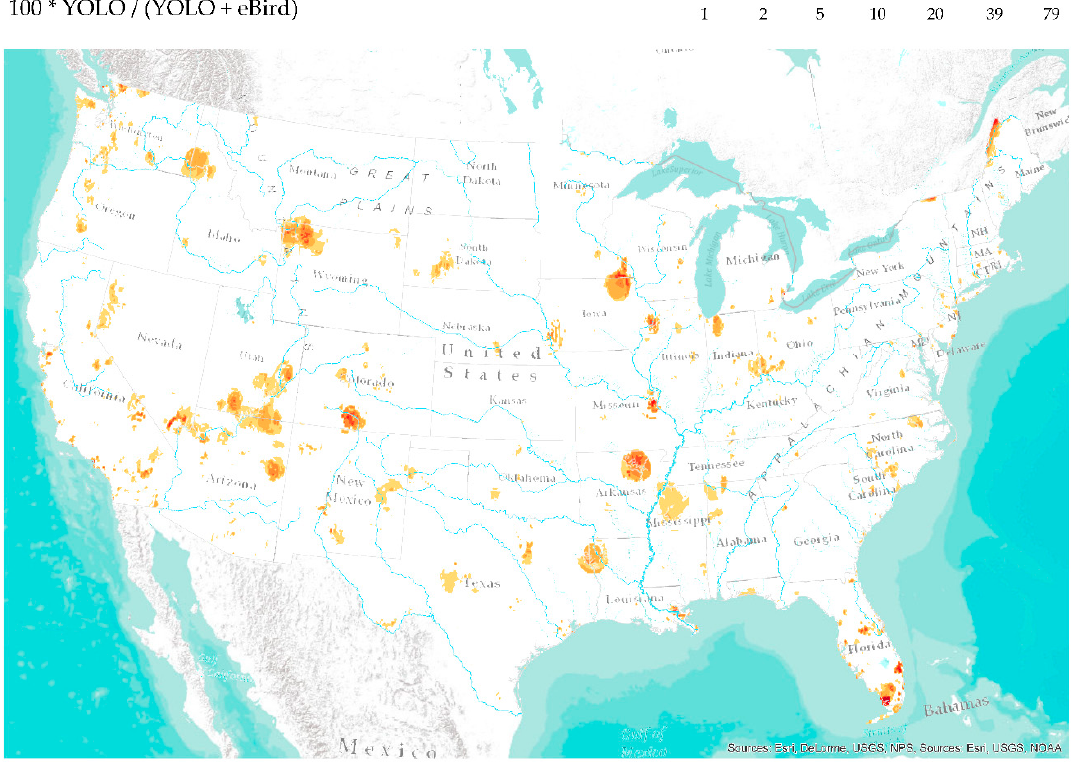
Figure 9. Percent of YOLO-detected Flickr bird images computed by an adaptive kernel based on a minimum threshold of 100 users that contain both Flickr and eBird users.